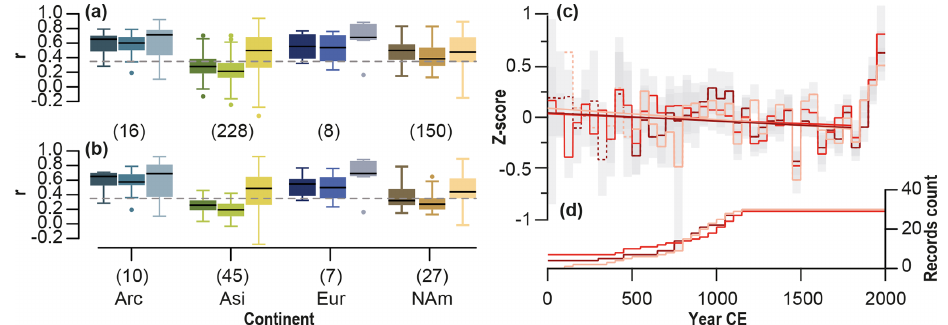
Figure 7. Effects of tree-ring calibration on long-term temperature trends. (a) Maximum correlation coefficients between NH individual site- level tree-ring records from the Arctic (Arc), Asia (Asi), Europe (Eur), and North America (Nam) and 1 × 1 ◦ CRU TS 4.01 June–September monthly temperature data over the period 1950–1980, divided by region, using 10-year high-pass-filtered data (left box), original data (central box), 10-year smoothed data (right box). Dashed line indicates the p <0.05 threshold. (b) Same as (a) using only records longer than 800 years and corresponding (c) 50-year binned composites divided by climate signal strength including records with the lowest ( n = 30; rose), medium ( n = 31; red), and highest ( n = 30; dark red) climate sensitivity. Light gray shadings indicate 95% bootstrap confidence intervals with 500 replicates and (d) temporal distribution of the